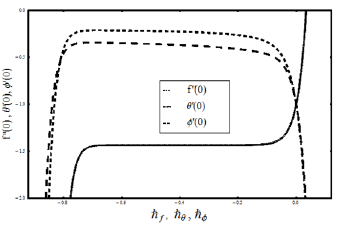
Figure 1. B { curves for functions f ( g ) , h ( g ) and w ( g ) at 21th order of approximations when l 1 ~ 0 : 3, b ~ 0 : 2, M ~ 0 : 5, Pr